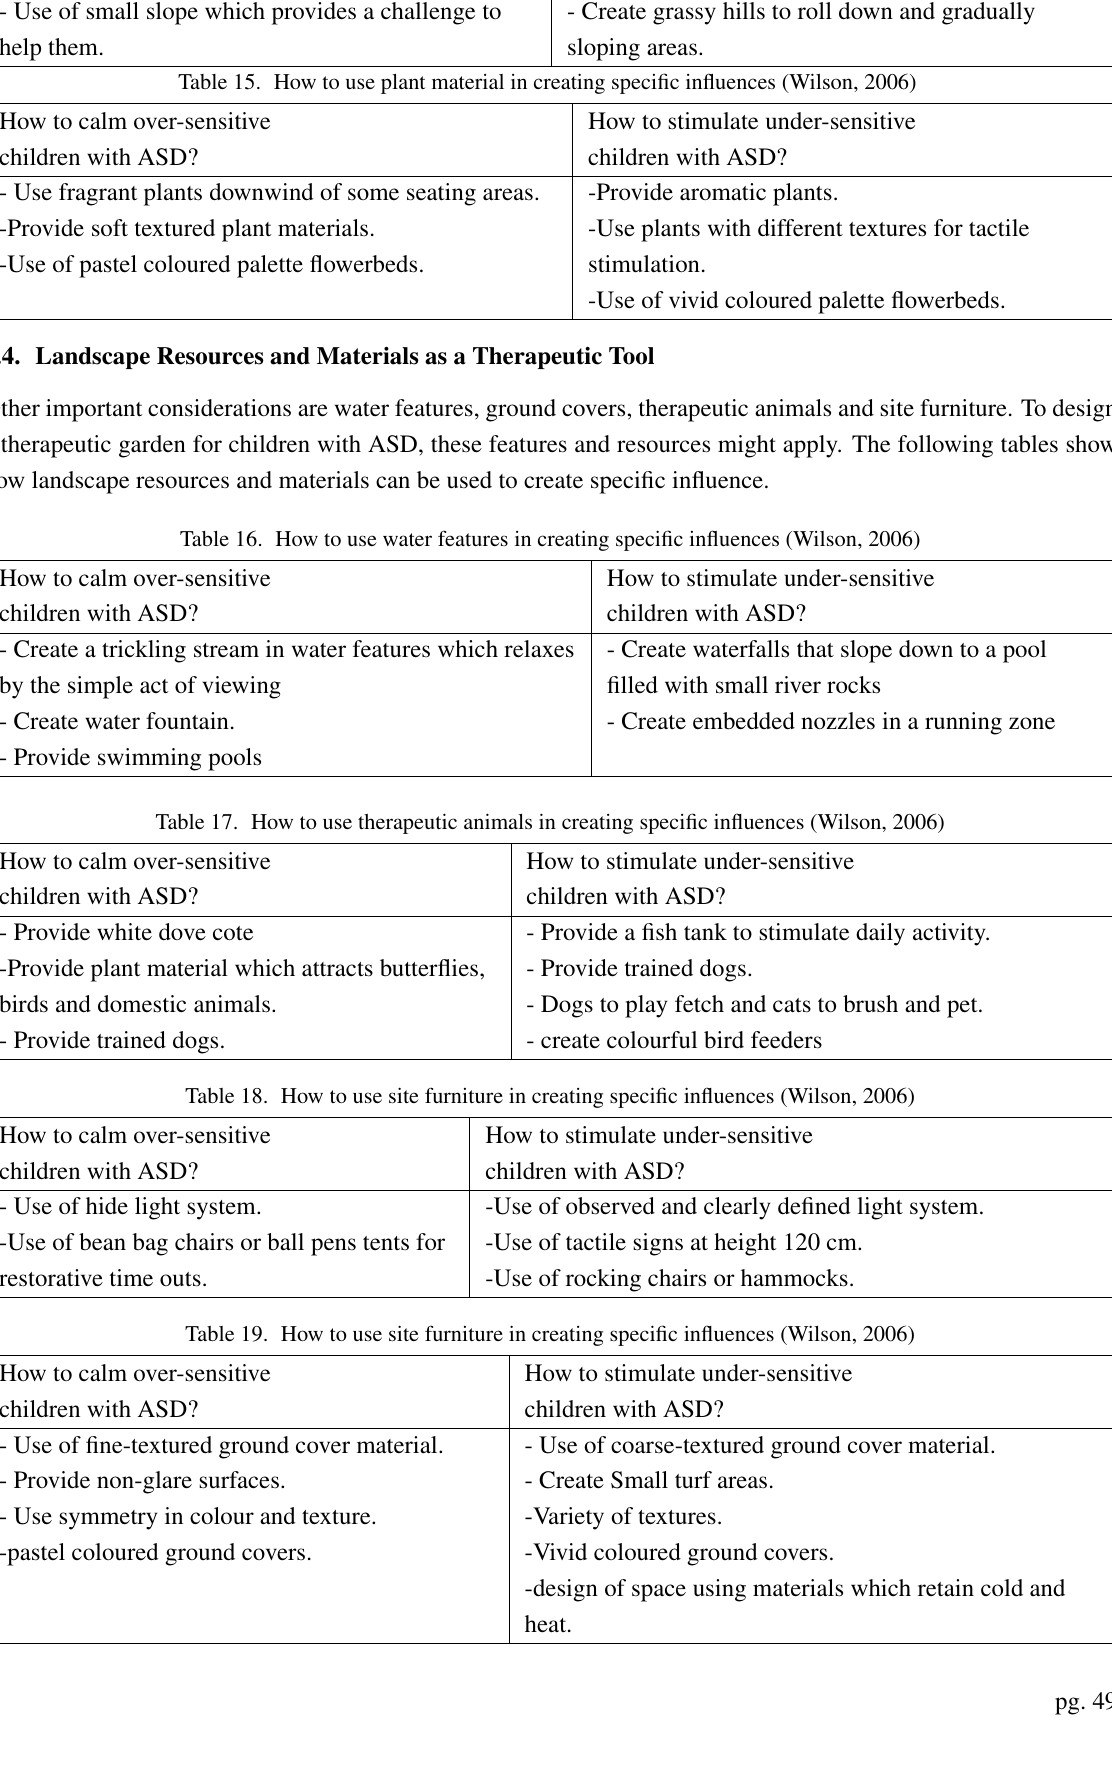
Table 15. How to use plant material in creating specific influences (Wilson, 2006)